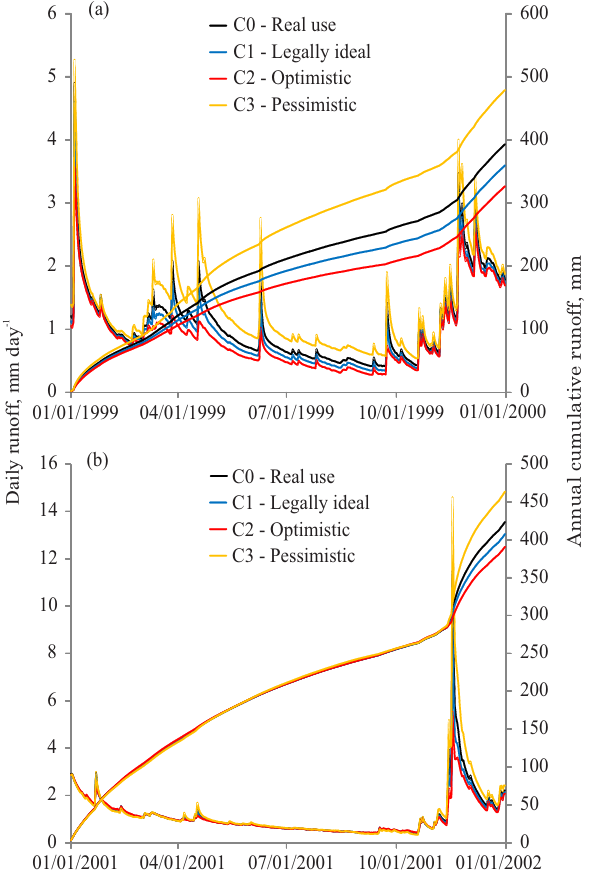
Figure 5. Hydrographs of SWAT-simulated daily and annual cumulative runoff, considering the proposed land use scenarios: (a) 1999 (calibration) and (b) 2001 (validation).